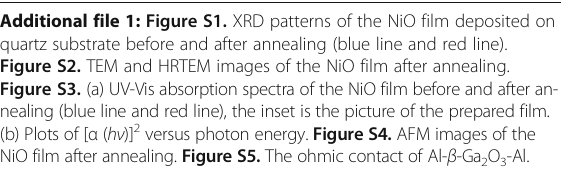
Additional file 1: Figure S1. XRD patterns of the NiO film deposited on quartz substrate before and after annealing (blue line and red line). Figure S2. TEM and HRTEM images of the NiO film after annealing. Figure S3. (a) UV-Vis absorption spectra of the NiO film before and after an- nealing (blue line and red line), the inset is the picture of the prepared film. (b) Plots of [ α ( h ν )] 2 versus photon energy. Figure S4. AFM images of the NiO film after annealing. Figure S5. The ohmic contact of Al- β -Ga 2 O 3 -Al. Abbreviations AFM: Atomic force microscope; ITO: Indium tin oxide; TEM: Transmission electron microscope; UV: Ultraviolet; XPS: X-ray photoelectron